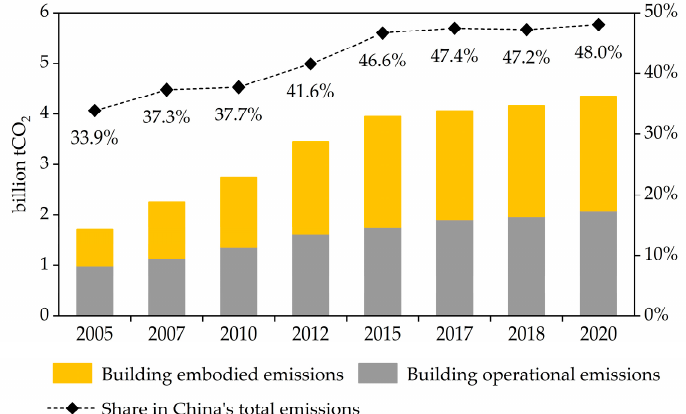
Figure 18. Embodied and operational carbon emissions of China’s building sector (2005–2020).